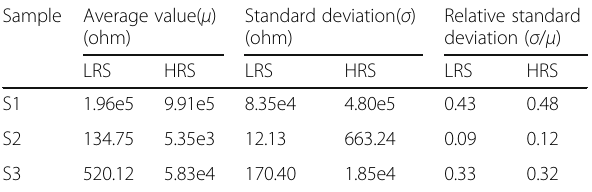
Table 1 The cycle-to-cycle variation characteristic of three samples Sample Average value( μ ) (ohm)